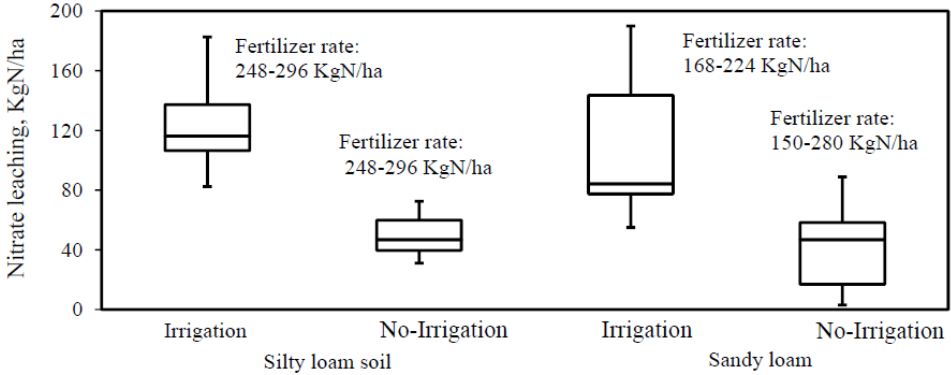
Figure 14. Irrigation effect on nitrate leaching in two different soil types through continuous corn field (two articles in silty loam soil and two articles in sandy loam soil were used for analysis).